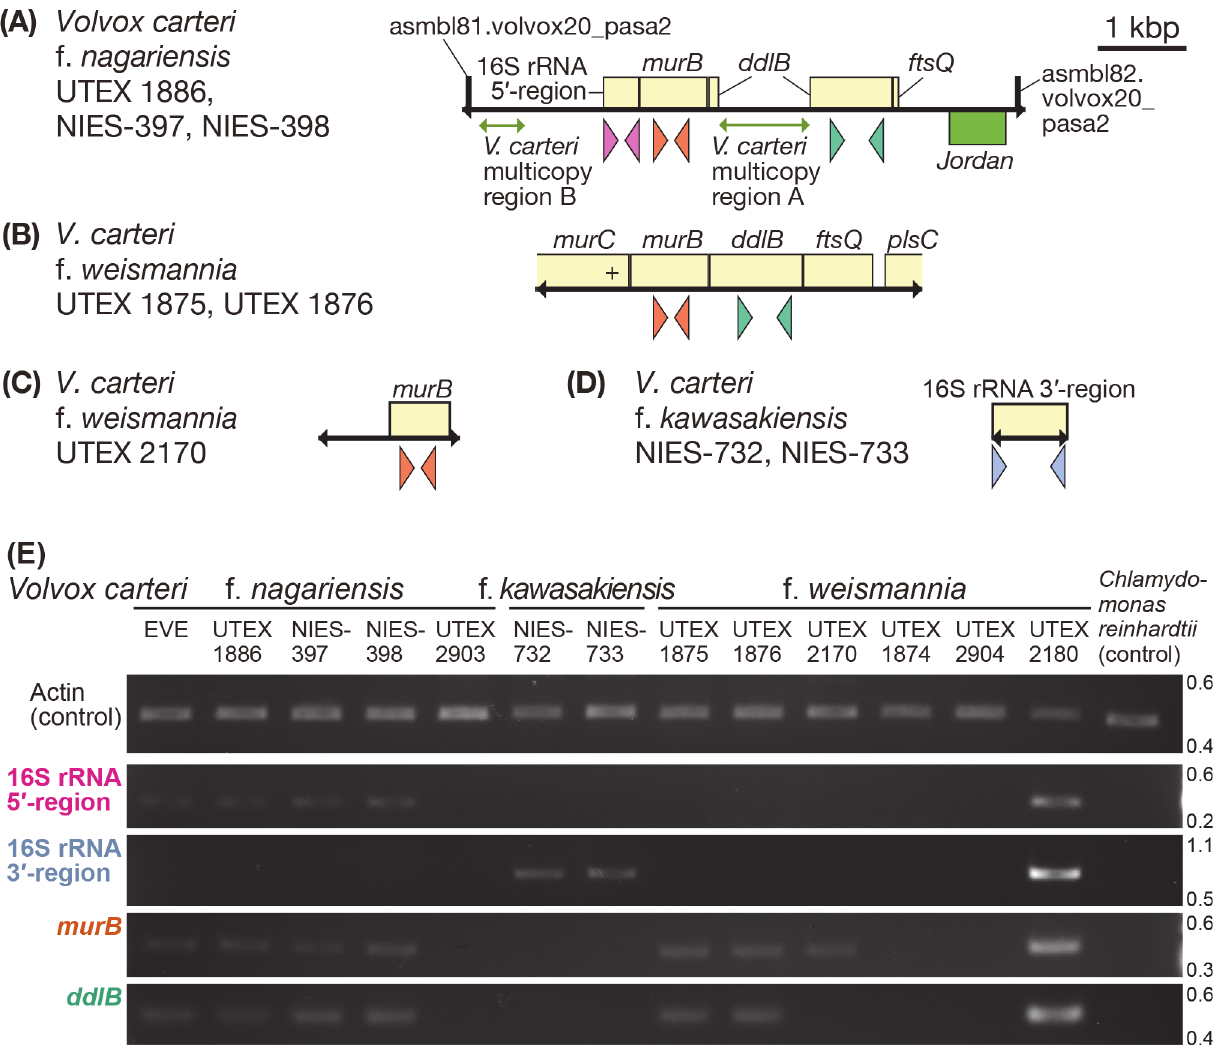
Fig 2. Rickettsial gene-like sequences possibly located in the nuclear genomes of Volvox carteri strains. Schematic representations of arrangements/ synteny (A-D) in, and semi-quantitative genomic PCR data (E) from, several rickettsial gene-like sequences possibly located in the nuclear genomes of V . carteri strains. Coding DNA sequence (CDS)-like regions are shown as boxes. Rickettsial CDS-like regions are shown in pale yellow, the V . carteri transposon Jordan -like region in green and others in black. Placement of boxes above/below the line indicates the gene direction (from left-to-right or right-to- left, respectively). Black double-headed arrows on the baseline indicate the regions sequenced in the present study. Colored triangles under boxes indicate the primers used for semi-quantitative genomic PCR (16S rRNA gene 5 0 -region: magenta, 16S rRNA gene 3 0 -region: light blue, murB : orange, ddlB : green; Fig. 2E). For accession numbers of sequences used in this figure, see S3 Table. (A) Sequences including rickettsial CDS-like regions of V . carteri f. nagariensis strains UTEX 1886, NIES-397 and NIES-398. (B) Sequences including rickettsial gene homologs of V . carteri f. weismannia strains UTEX 1875 and UTEX 1876. Plus (+) indicates a frameshift deletion. (C) Sequence including rickettsial murB -like sequence of V . carteri f. weismannia strain UTEX 2170. (D) Sequences including rickettsial 16S rRNA gene-like sequences of V . carteri f. kawasakiensis NIES-732 and NIES-733. (E) Semi-quantitative genomic PCR of rickettsial genes and gene-like sequences. Each rickettsial gene-like sequence was amplified via genomic PCR using rickettsia-specific primer sets (see Materials and Methods). The positions of primer sets with reference to target positions are shown in both Fig. 1 and this Fig. 2. As a control, the actin gene was amplified. Chlamydomonas reinhardtii strain CC-503 was used as negative control.